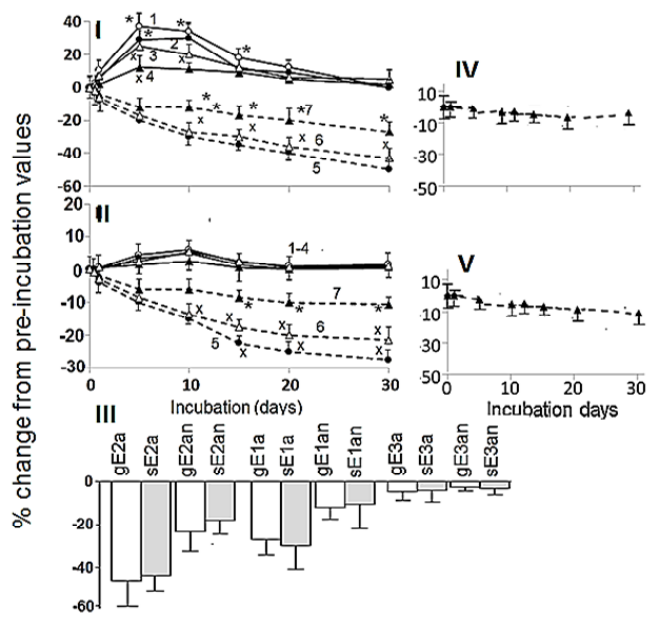
Figure 5. Effects of aerobic and anaerobic incubations on fate of conjugated and free estrogens in manure samples . I- aerobic and II- anaerobic : Plots 1 to 4, respectively, represents the time-course of change in estrogenic activity, free β estradiol (fE2), free estrone (fE1) and free estriol (fE3), while plots 5 to 7, respectively, represents conjugated β estradiol (cE2), conjugated estrone (cE1) and conjugated estriol (cE3) in manure samples incubated in aerobic (I) and anaerobic (II) environment; III: Percentage decrease in estrogen glucuronides (gE2, gE1 and gE3) and estrogen sulfates (sE2, sE1 and sE3) in manure at 30-days after aerobic (a) or anaerobic (an) incubation. Both conjugates were comparably sensitive to manure processing; IV- aerobic and V- anaerobic: Time-course of change in cEs in sterilized-manure following aerobic or anaerobic incubations; values are mean ± SD, n = 27, * significant ( p < 0.05) compared with control and x: significant when compared with corresponding plot 1 values for free estrogens and plot 7 values for conjugated